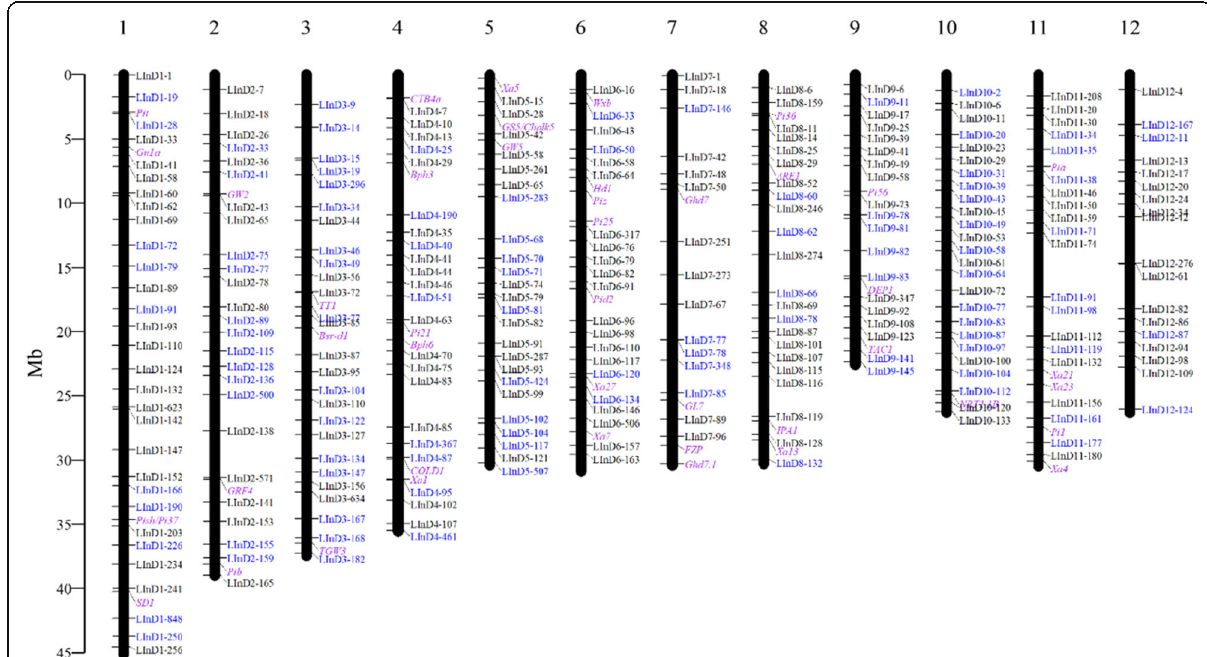
Fig. 4 The physical map of the 55 breeding markers and the 312 LInDel markers. The breeding markers are labeled in purple, the markers with a PIC value larger than 0.5 are labeled in blue, and the markers with a PIC value smaller than 0.5 are labeled in